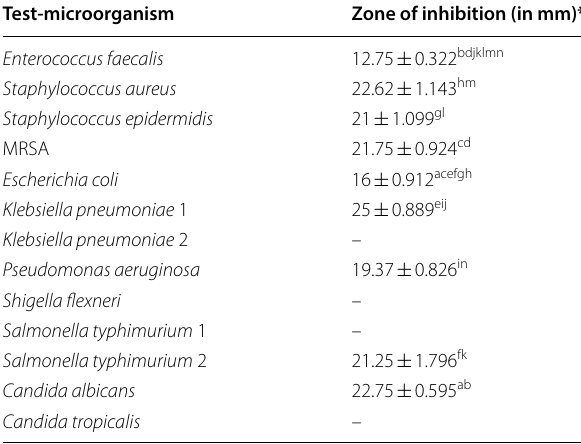
Table 1 Antimicrobial activity of 10% aqueous extract of Berberis aristata against some potential pathogens